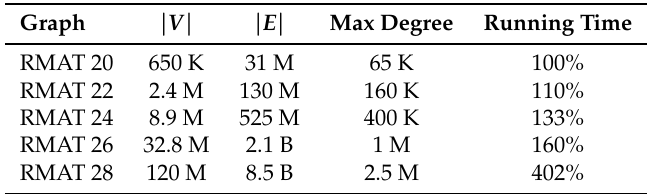
Table 5. General statistics (size) about the RMAT graphs as well as the relative running times of balanced-partitioning algorithm on these